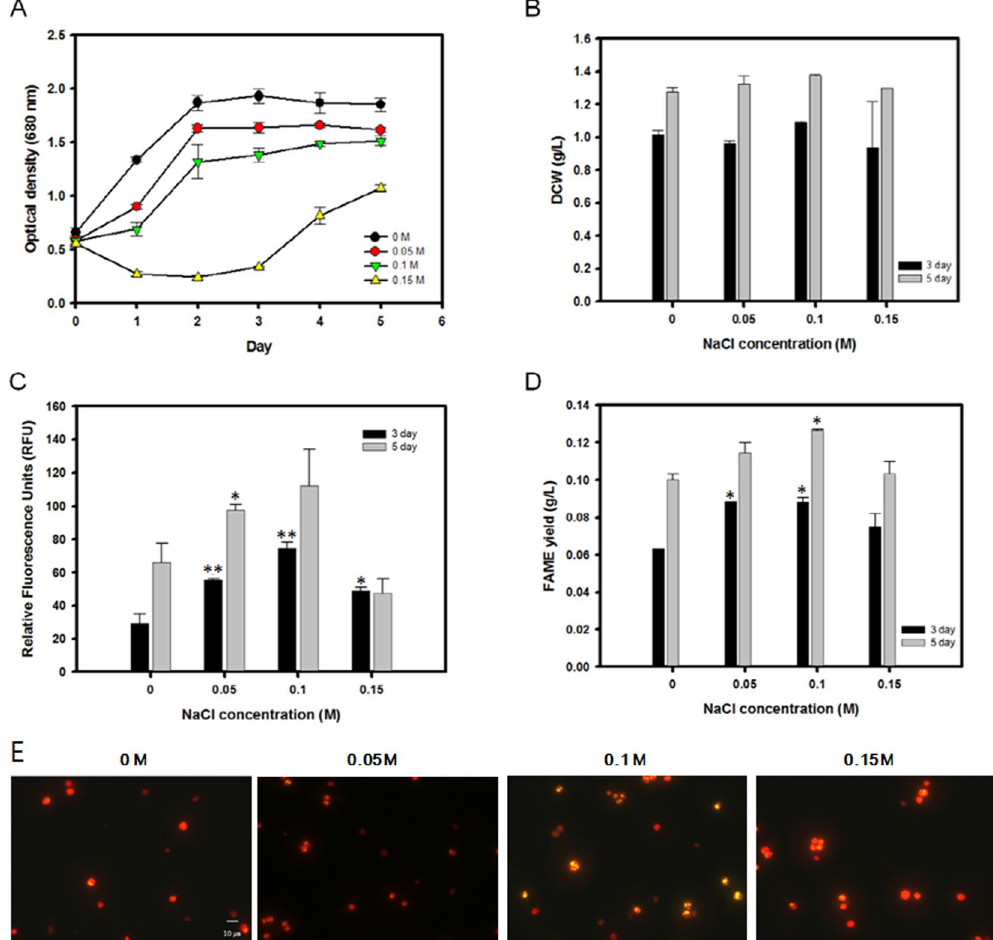
Figure 2. Cell proliferation and lipid accumulation of C . reinhardtii under various levels of osmotic stress. ( A ) Time course of cell growth (O.D. 680 nm). ( B ) Total dry cell weight at 3 and 5 days after osmotic stress induction. ( C ) Nile red fluorescence measurement at 3 and 5 days after osmotic stress induction. ( D ) Total lipid yield measured by in situ transesterification into FAME followed by gas chromatography. ( E ) Nile Red fluorescence microscopy of the cells at 0, 0.05, 0.10, and 0.15 M concentrations of NaCl. Data are represented as mean ± SD ( n = 3). Significant differences were determined by Student’s t-test and indicated by asterisks ( * P < 0.05, ** P < 0.01, *** P < 0.001).